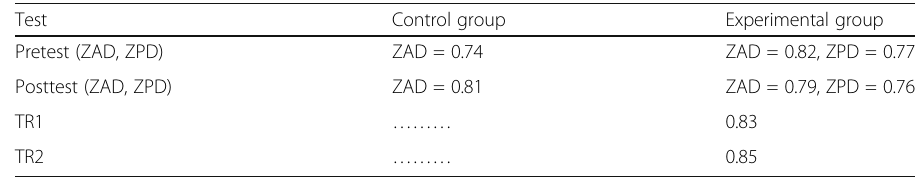
Table 4 Inter-rater